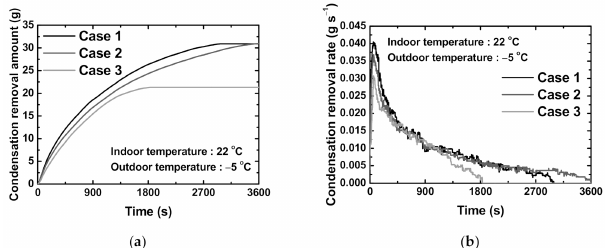
Figure 7. Comparison of Cases 1–3: ( a ) condensation removal quantity; ( b ) condensation removal rate over time.